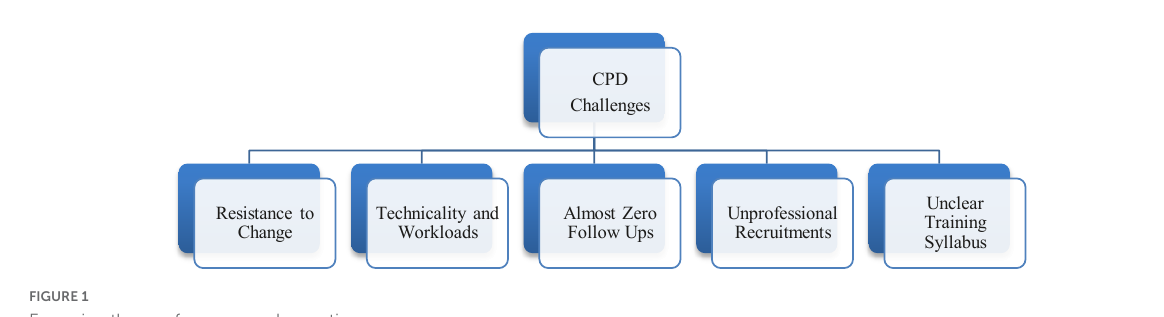
“The biggest challenge is actually from the teachers. I would say that only 40% of the teachers have the characters of ideal teachers. Meaning they have the passion to care for the students, responsible for their jobs, commitment. This is something that is still lacking . ..